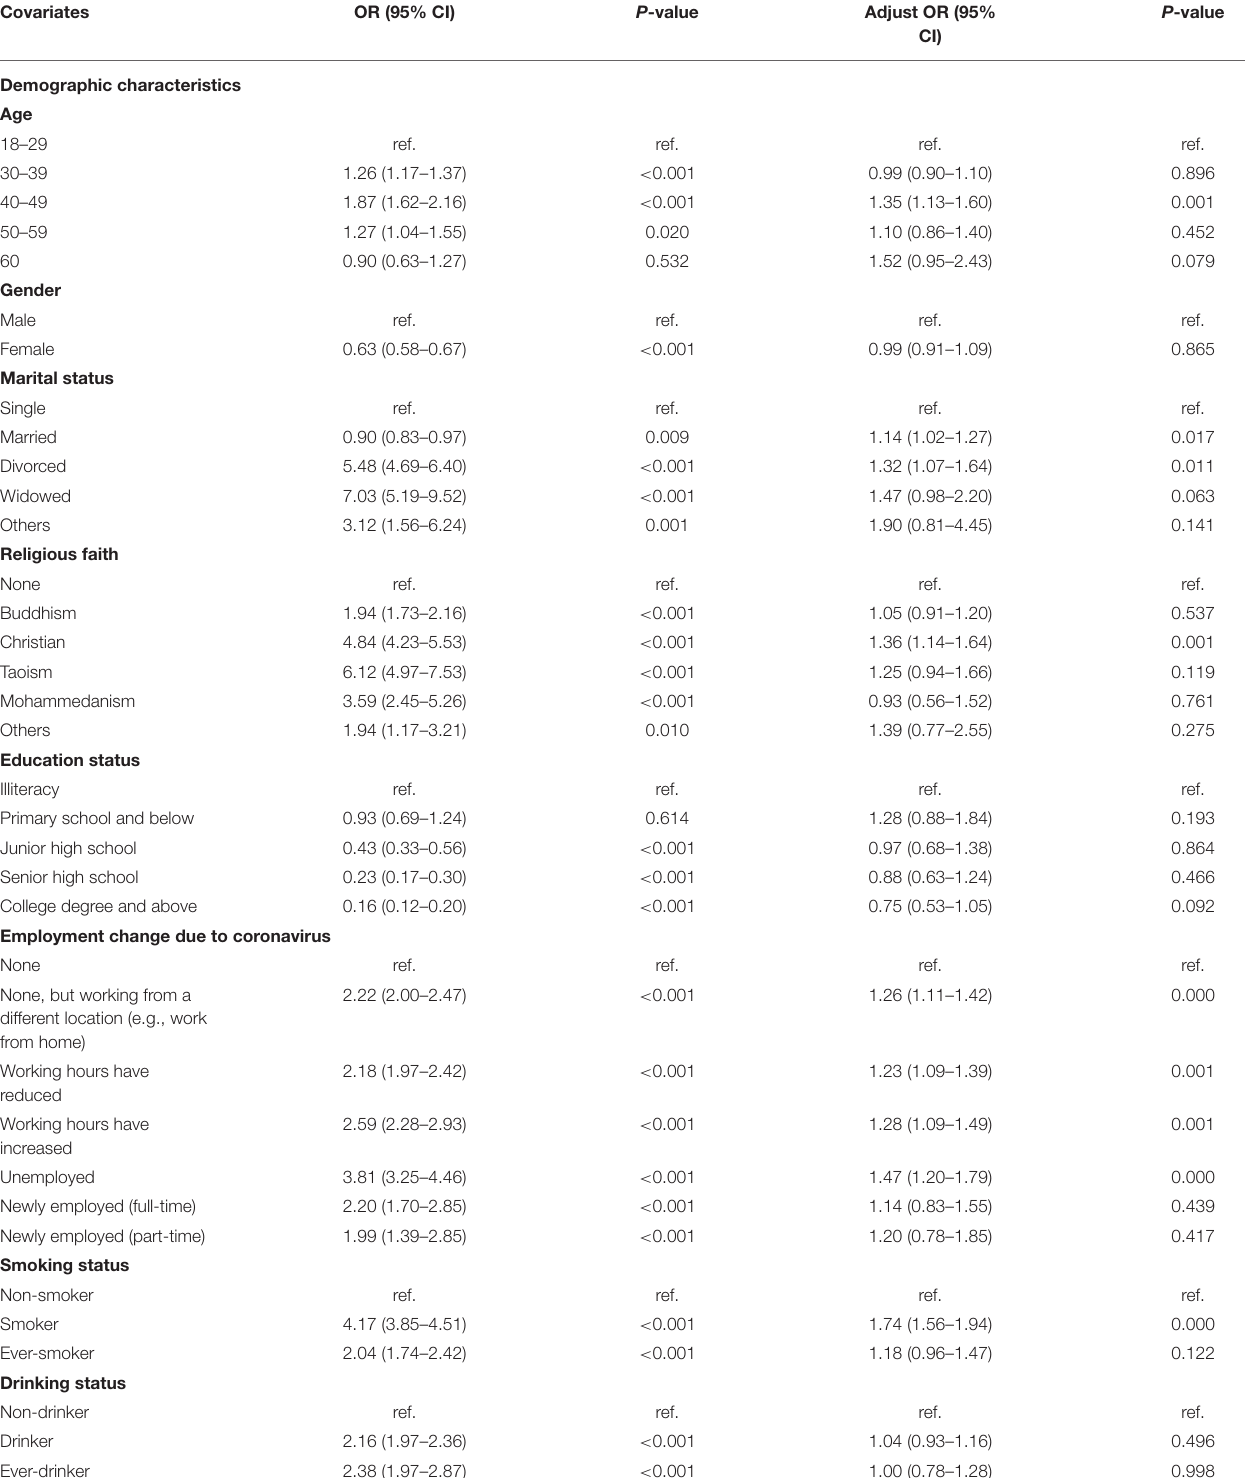
TABLE 2 | Associations of demographic factors, awareness of COVID-19 pandemic, awareness of COVID-19 vaccine with COVID-19 vaccination rate (individual regressions) ( n = 29,925). Covariates OR (95% CI) P -value Adjust OR (95%